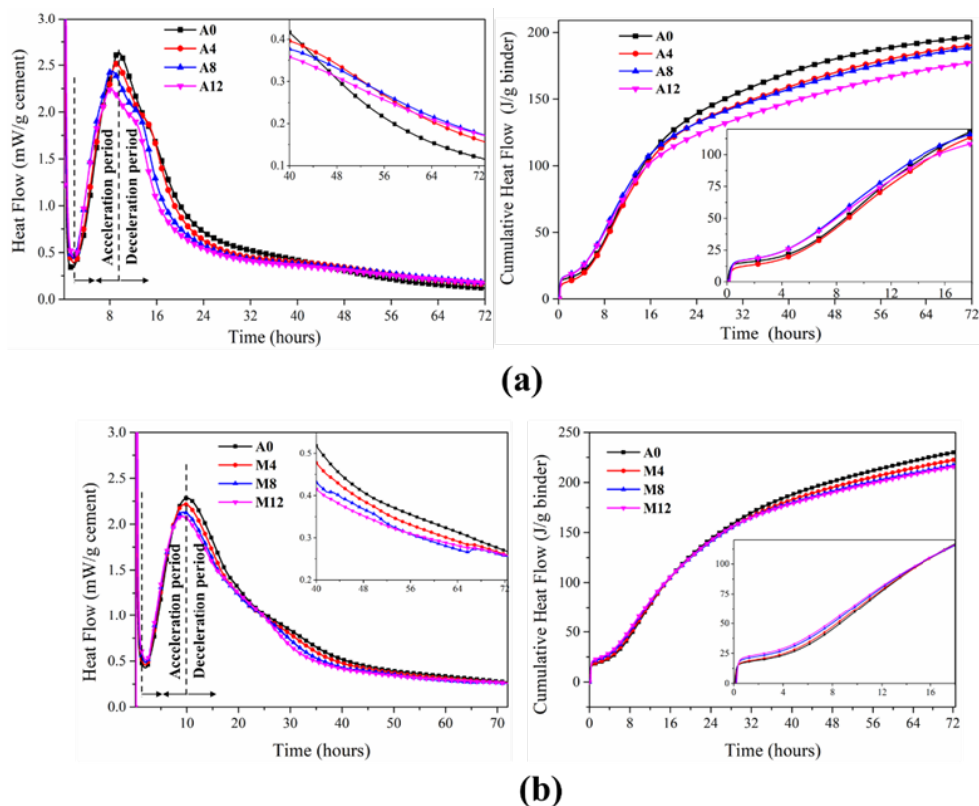
Figure 13. Heat release of cement pastes with time change: ( a ) CAG; ( b ) CMT.